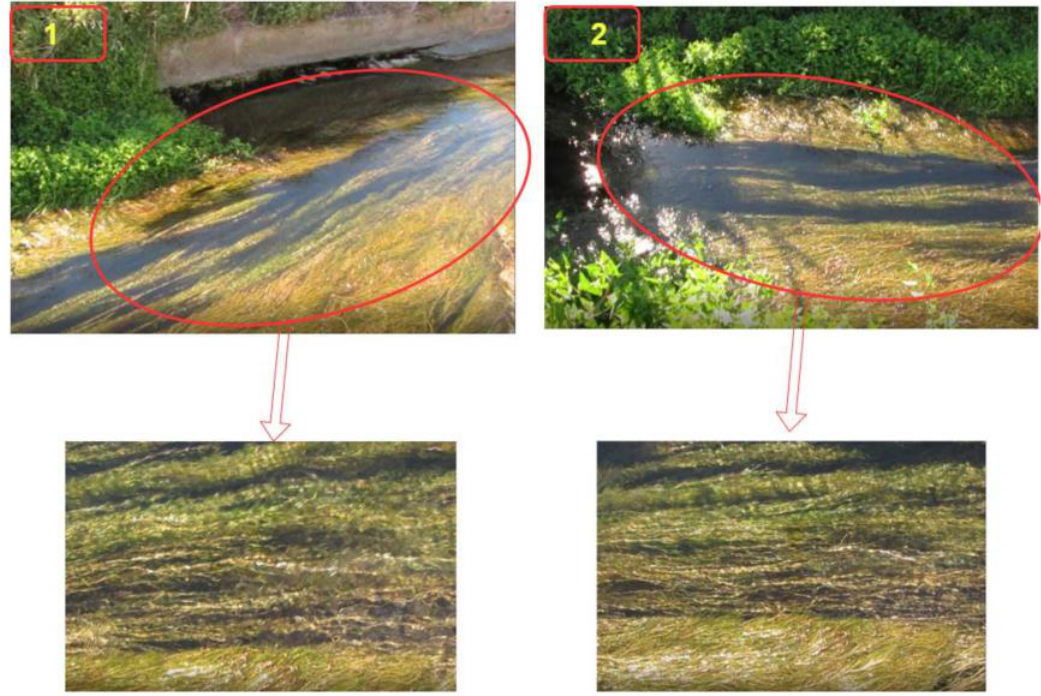
Figure 10. Single frames taken from the video sequences and their corresponding regions of